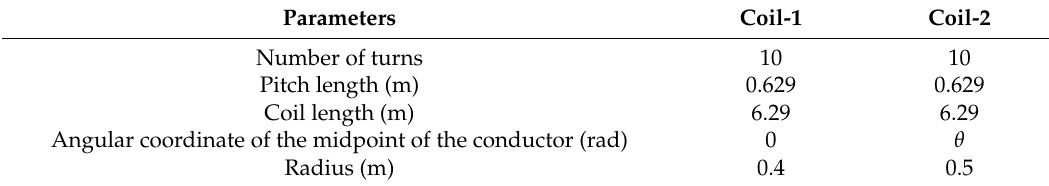
Figure 9. Rotation angle ( θ ) dependence of the mutual inductance ( M 12 ). Table 3. Geometric parameters of the coils in Figure 2 (2nd comparison).